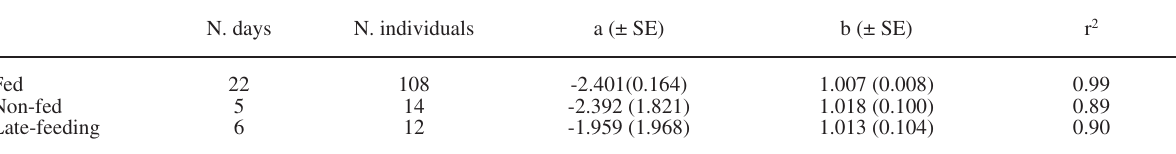
Table 1. – linear regression parameters for the relationship between observed increments (dependent variable) and real days (independent variable) for each feeding treatment for which more than 4 days were available. n is the number of observations, a is the intercept, b is the slope, r 2 is the determination coefficient and se is the standard error. All regressions were significant at p<0.0001. n. days Fed